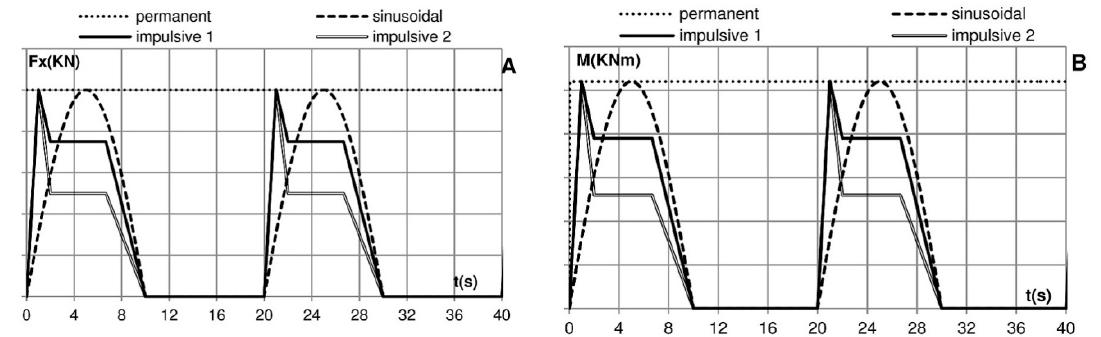
Figure 7. Shape of the load states B and C in the time domain: ( A ) horizontal force (Fx); ( B ) overturning moment (M).